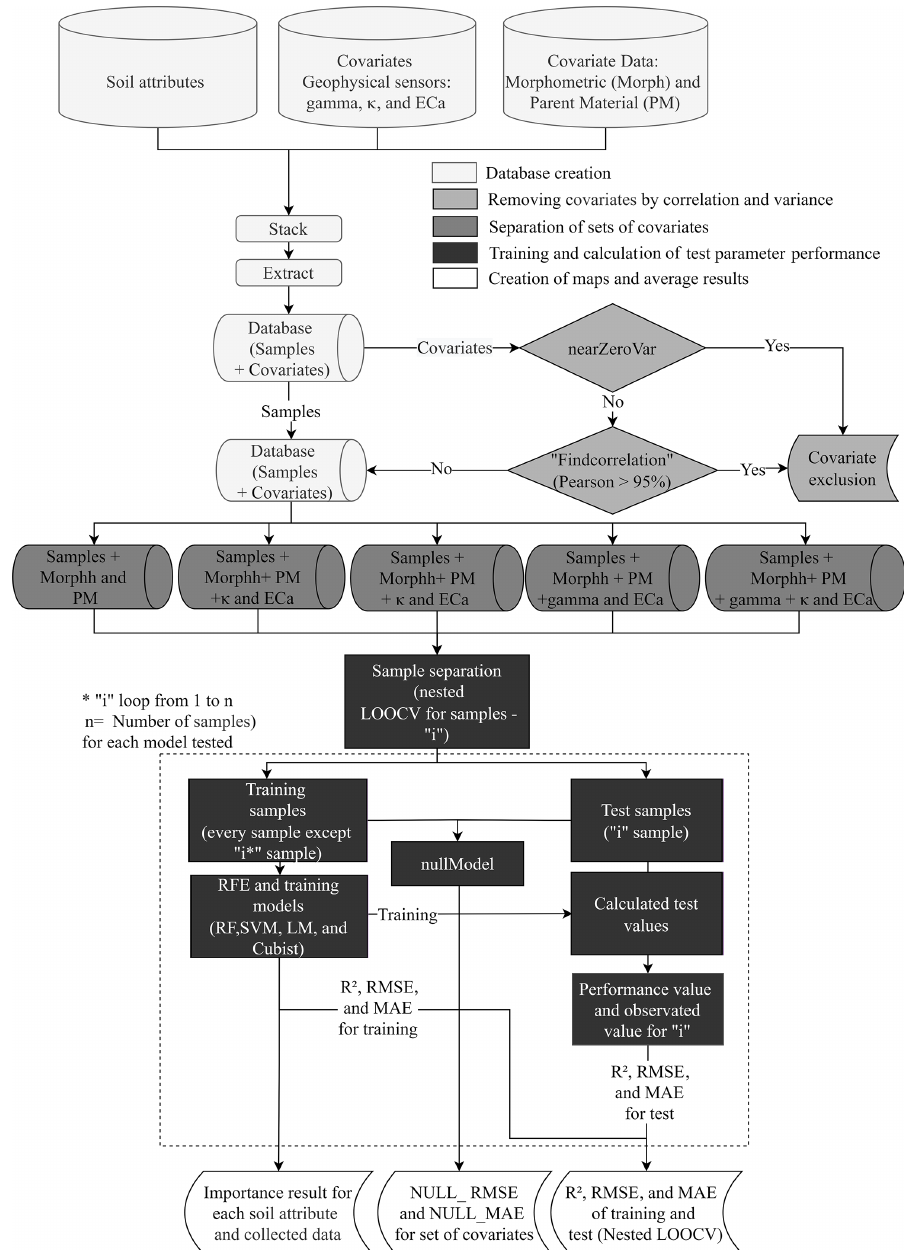
Figure 3. Methodological flowchart showing the sequence of methodologies applied for soil and geophysical attribute prediction. The most accurate model among Cubist, random forest (RF), support vector machines (SVMs), and linear models (LMs) was selected to model and map the geophysical and soil